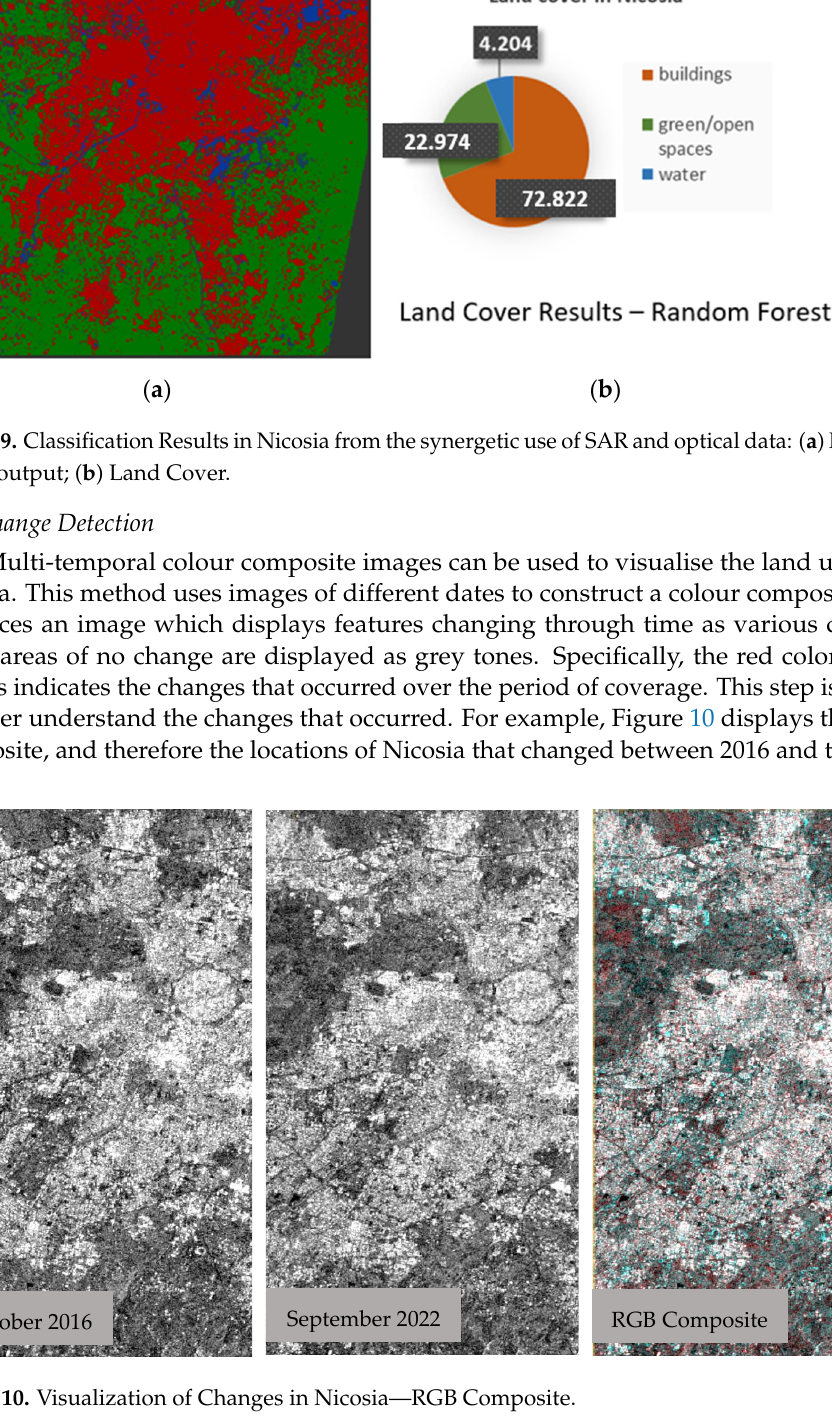
( b ) Figure 8. Classification Results in Limassol from the synergetic use of SAR and optical data: ( a ) Random Forest output; ( b ) Land Cover. Based on the assessment and the interpretation of the classification maps, the